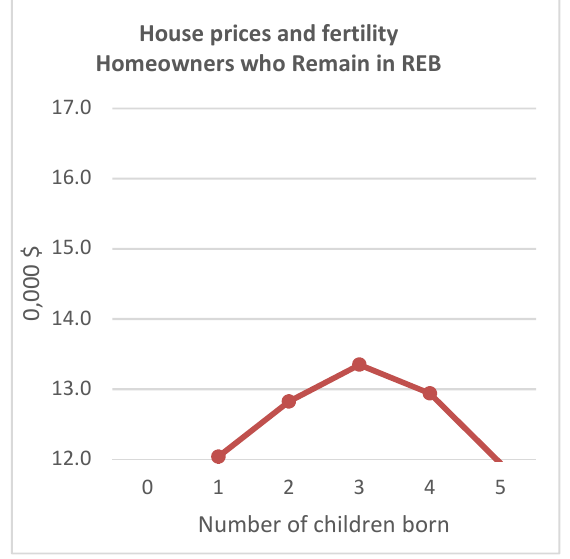
Figure 3: Average housing price and total number of children born for women who gave birth in the previous year